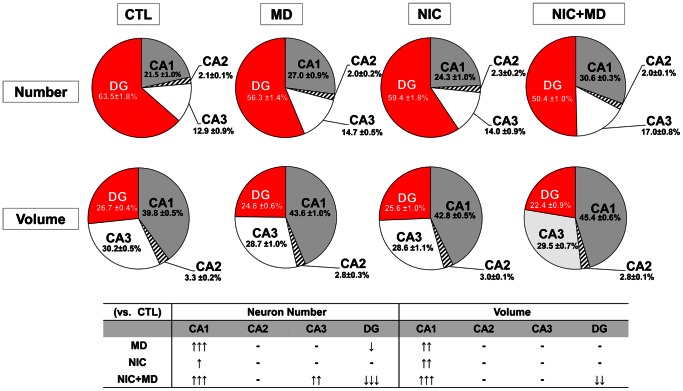
Fractional composition of CA1, CA2, CA3 and DG in P14 rat hippocampi after prenatal nicotine and/or maternal deprivation.The data for each hippocampal subregion is presented as a percentage of total neurons or neuronal volume of the hippocampus. The table summarizes data presented in pie graphs. Direction of arrows denotes relative increase (↑) or decrease (↓) in fractional composition of neuron number or volume compared to control animals. ↑ or ↓, p<0.05; ↑↑ or ↓↓, p<0.01; ↑↑↑ or ↓↓↓, p<0.001.